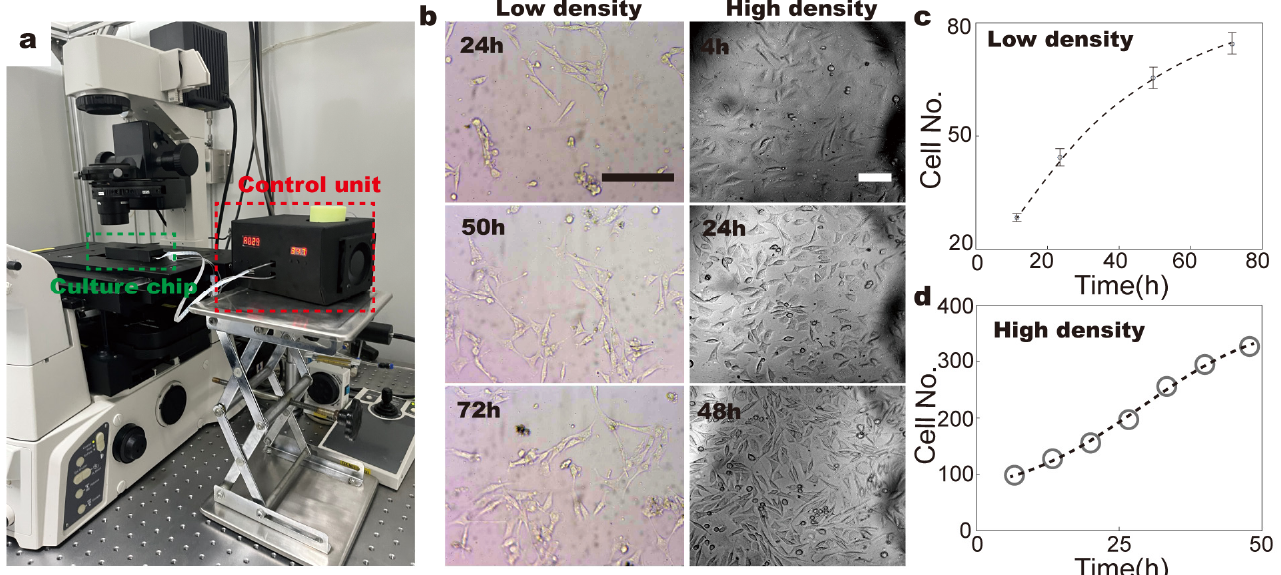
Figure 3. Application of the fluidic-culture chip in live-cell imaging. ( a ). Application of fluidic-culture chip in Inverted Fluorescence Microscope. ( b ). Cell line 3T3 fibroblasts at different seeding densities were cultured on chip for more than 48 h; the field of view is 340 μ m × 250 μ m. ( c ). Counts of 3T3 fibroblasts within 72 h, when being seeded at low cell density. ( d ). Proliferation of 3T3 fibroblasts at high seeding-cell density during 48 h culture on chip. Scale bars denote 100 μ m in all figures. Dots are experimental data, and the dashed line is the fitting curve.